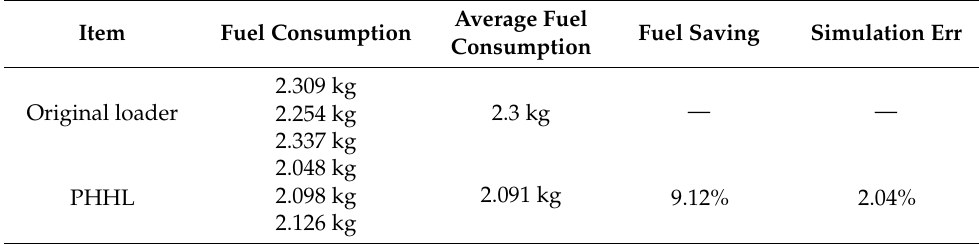
Table 8. Fuel consumption experiment results.